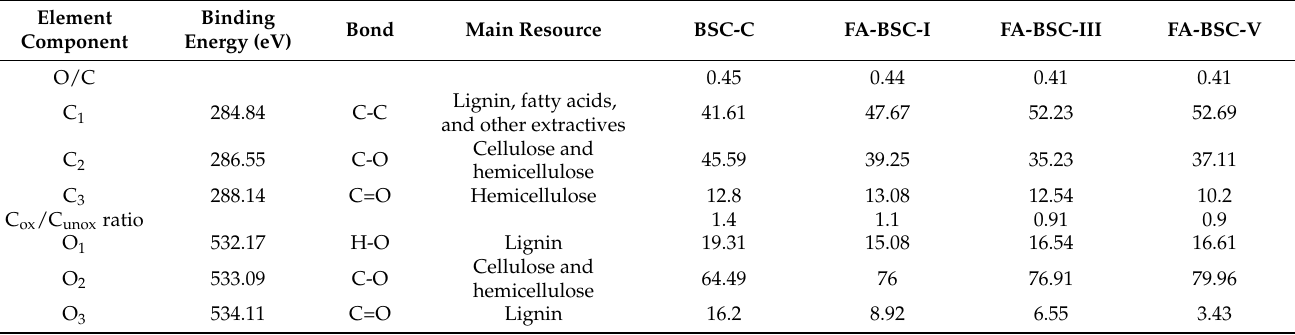
Table 7. Relative atomic compositions of